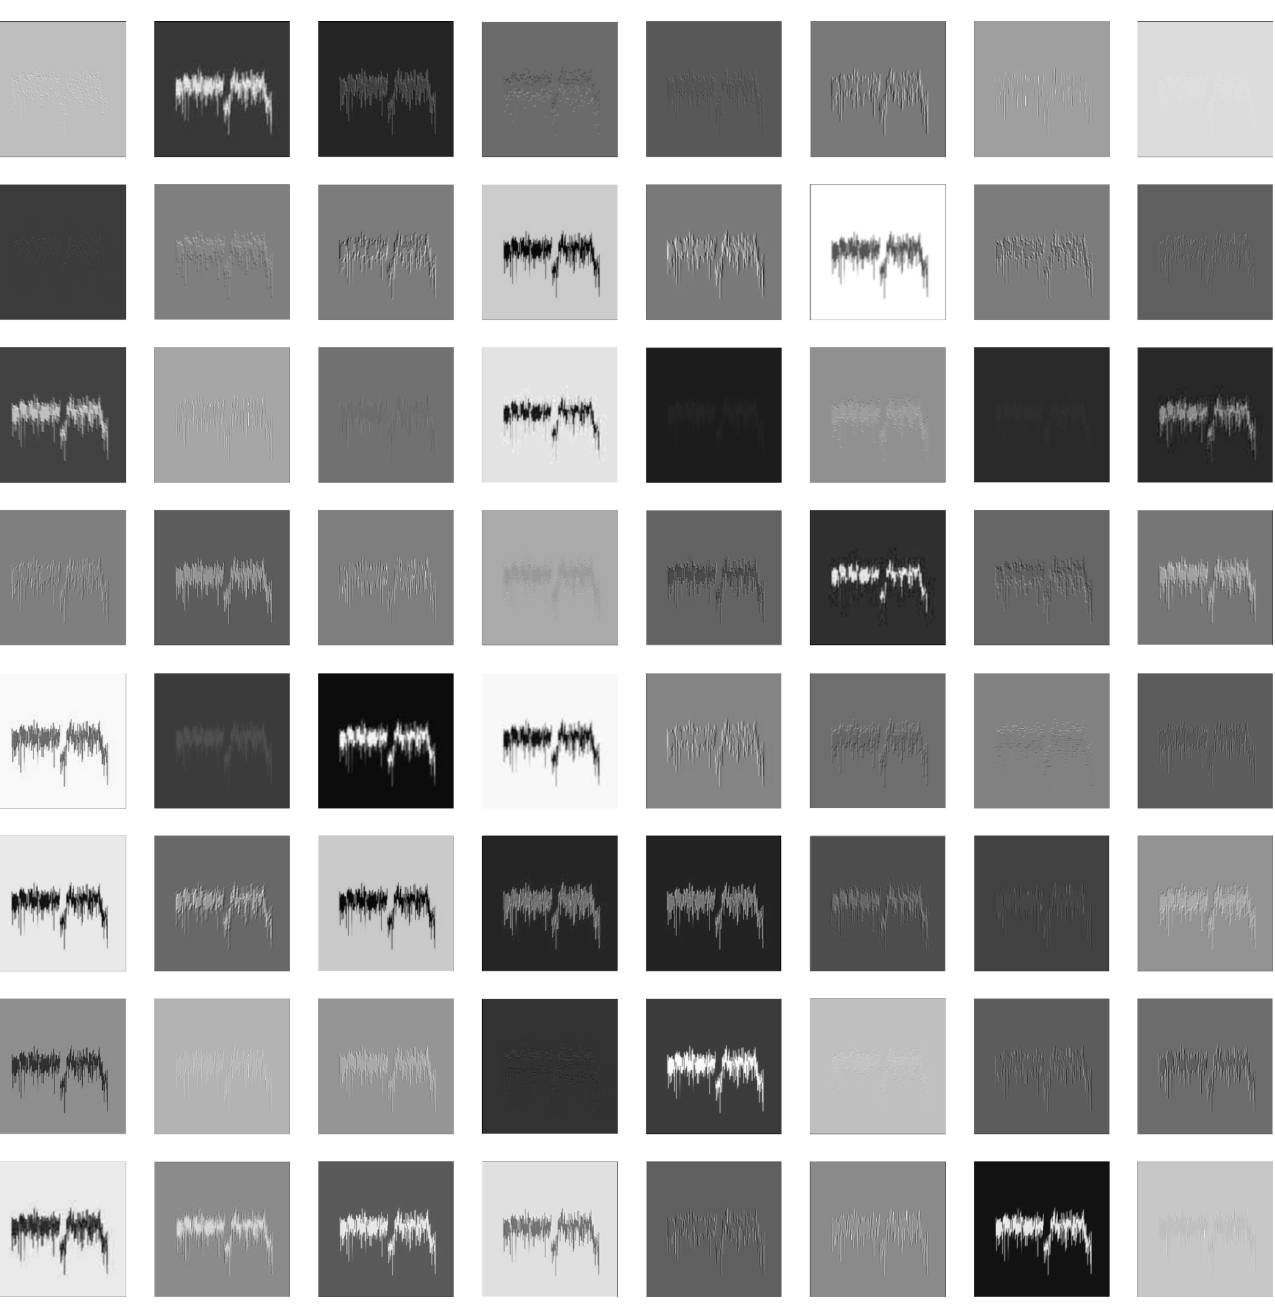
Figure 15. Feature Map Extraction Convolutional Layer